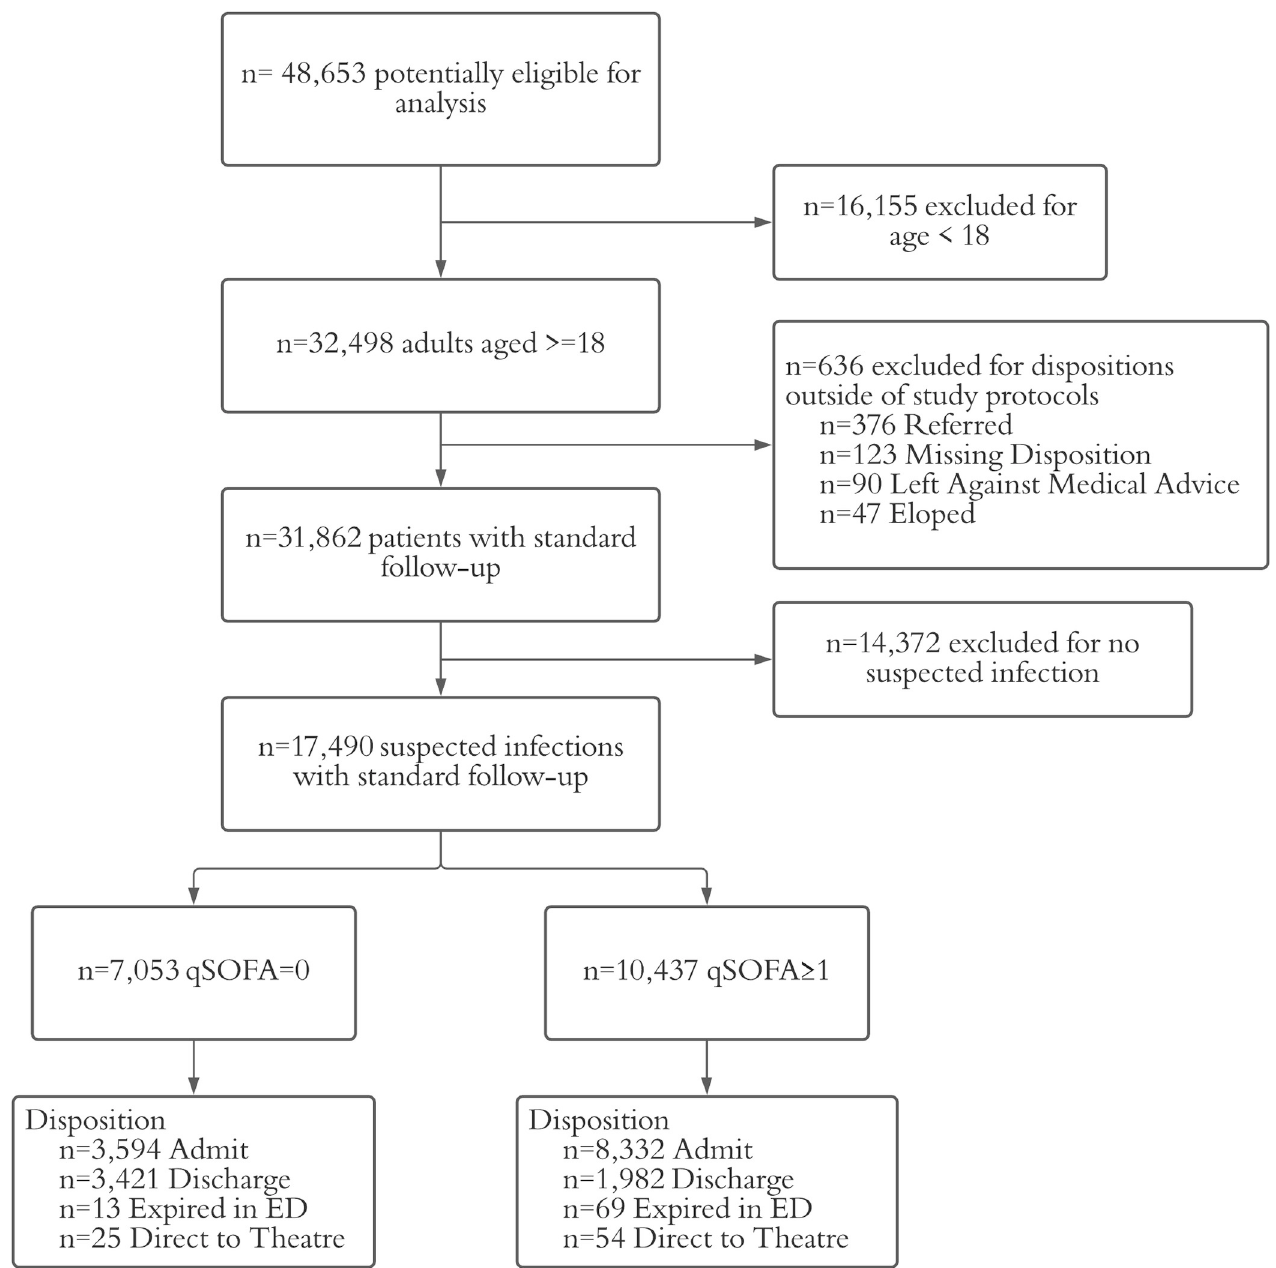
Fig 1. Patient visit inclusion and exclusion